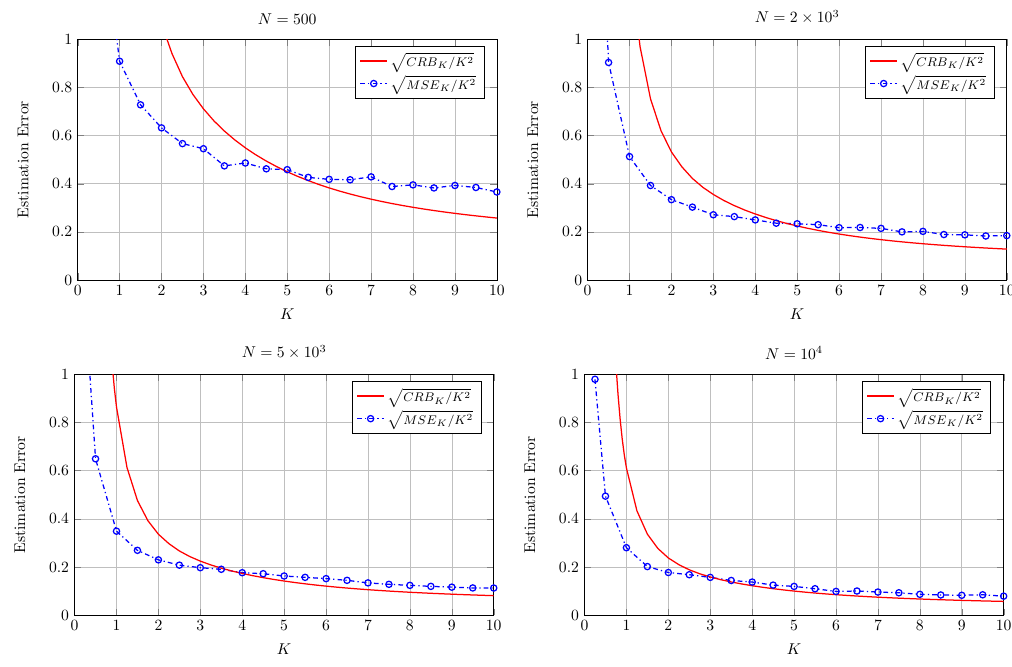
Figure 7. Square root of CRB K and MSE K normalized by K for the estimation of K using Equation (14) for ∆ = 0.5 and different number of observations N